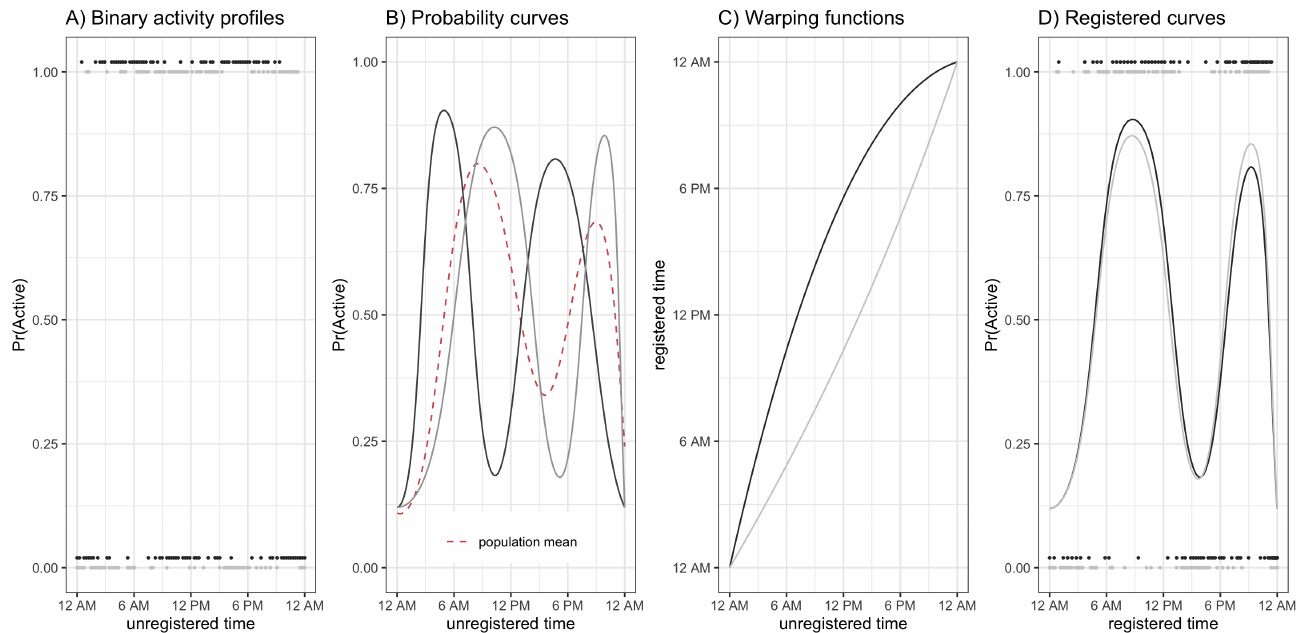
Figure 1. Toy Registration Example. Black and gray colors denote two separate subjects, and panels represent ( A ) binary activity profiles, ( B ) unregistered probability curves, ( C ) warping functions, and ( D ) binary activity profiles and probability curves that have been aligned using the warping functions in panel ( C